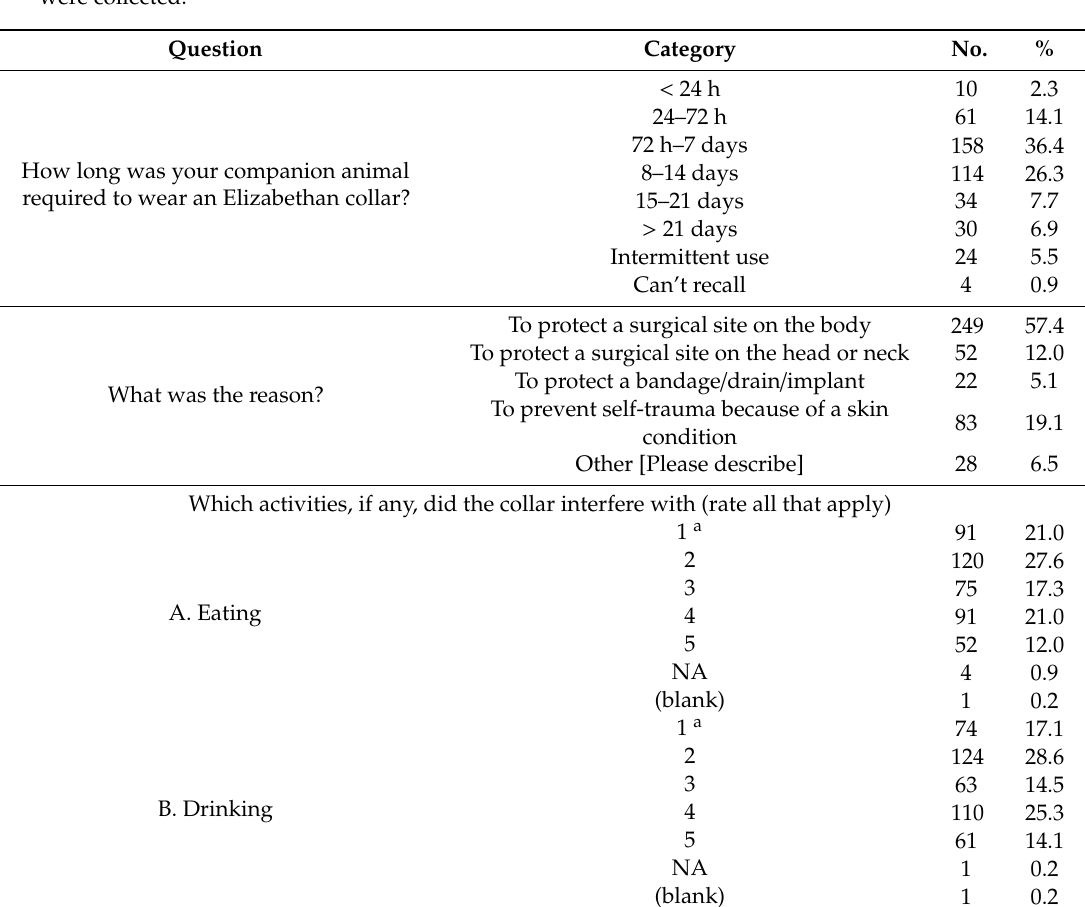
Table A1. Responses from participants in an online survey about welfare implications of Elizabethan Collar use on companion dogs and cats. The survey was conducted in 2019 and a total of 439 responses were